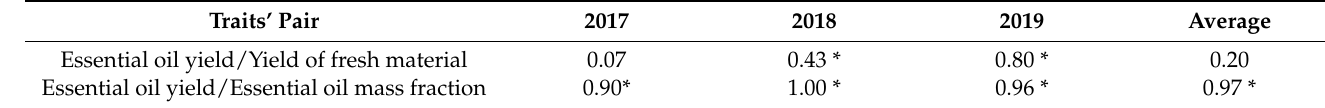
tively correlate (r = 0.97 on average over the research period) (Table 4).